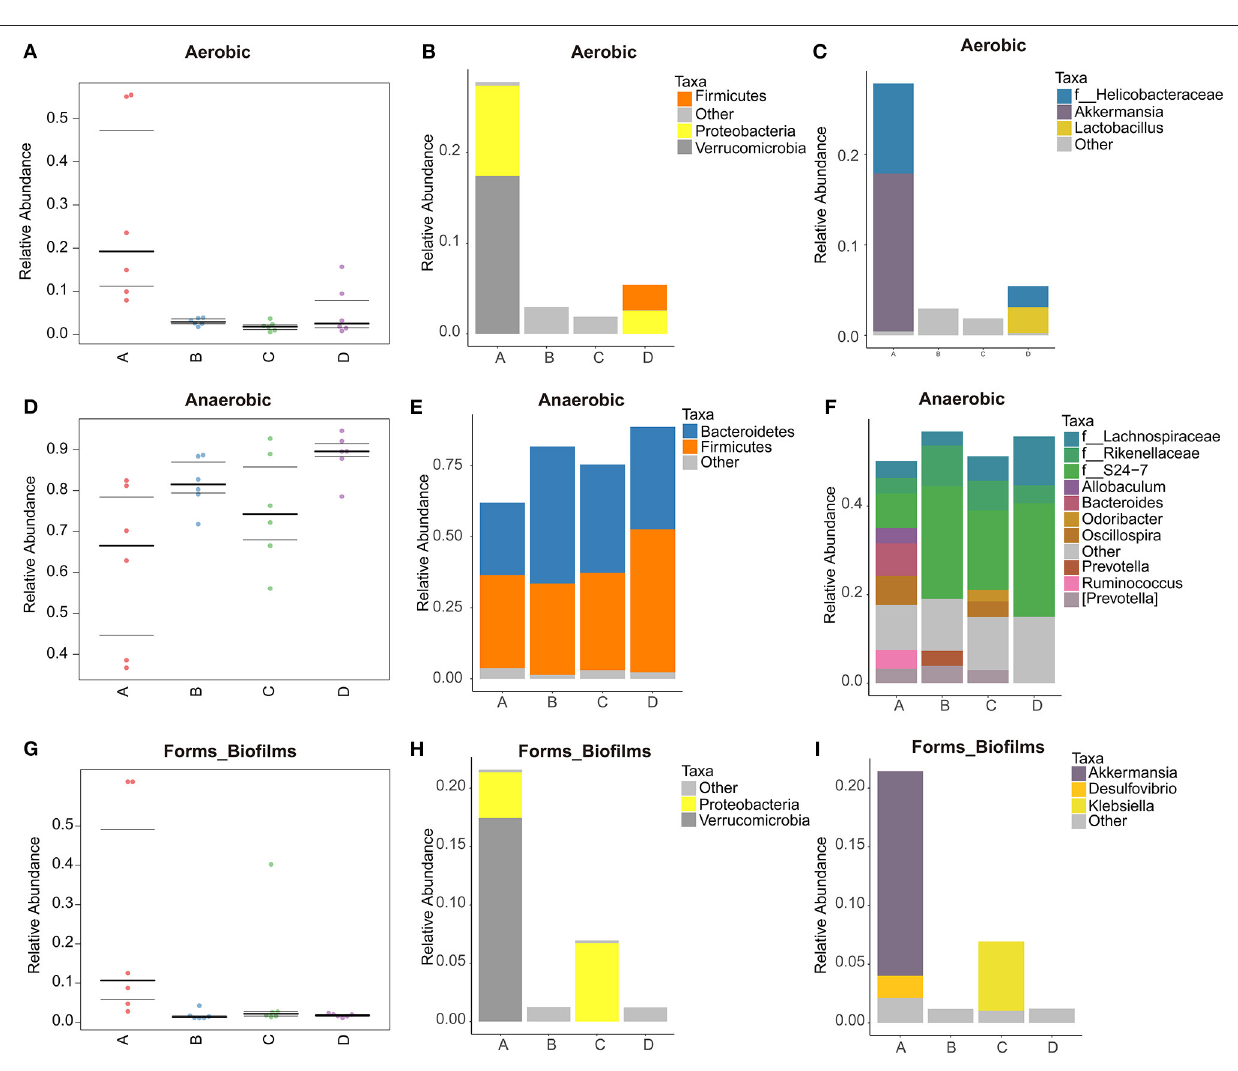
FIGURE 6 | Phenotype prediction and species histogram of BugBase. (A,D,G) : phenotype prediction map; (B,C,E,F,H,I) : species histogram. A: NT-free group; B: basal diet group; C: NT intervention group; D: model control